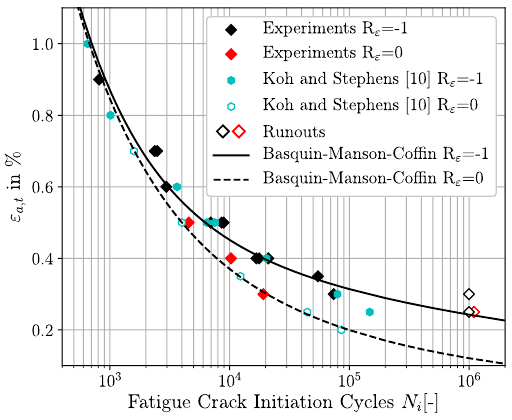
Figure 4. Experimental strain-controlled fatigue crack initiation test results of unnotched SAE 4150 (39 HRC) and ASTM A723 grade 1 (40 HRC) [10] at two different total strain ratios, R ε =